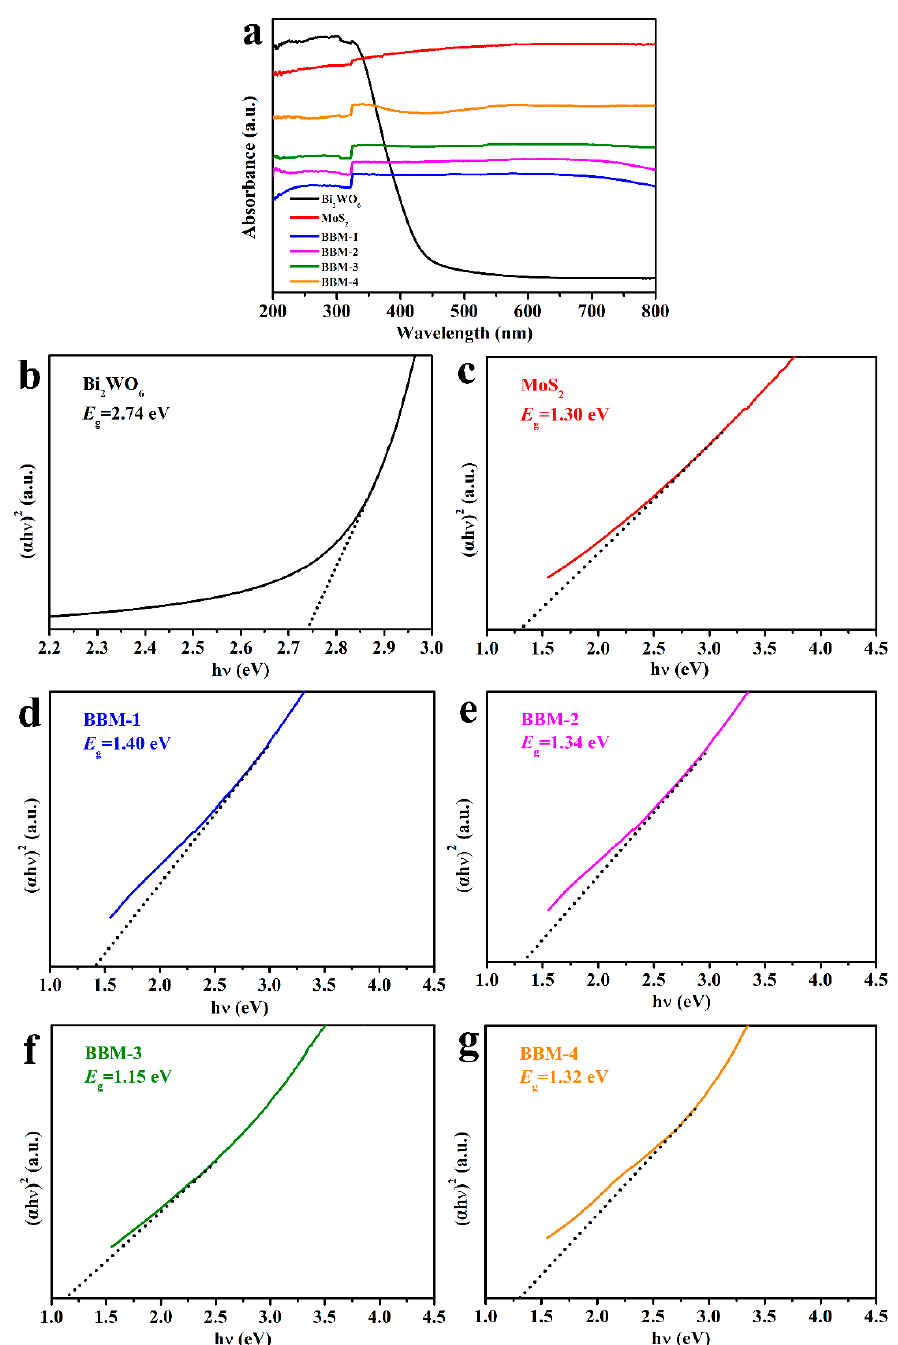
Figure 4. ( a ) Ultraviolet–visible (UV–vis) diffuse reflectance spectra (DRS) spectra of Bi 2 WO 6 , MoS 2 , BBM-1, BBM-2, BBM-3, and BBM-4. ( b – g ) Plot of ( α h ν ) 2 versus photon energy of Bi 2 WO 6 , MoS 2 , BBM-1, BBM-2, BBM-3, and BBM-4.